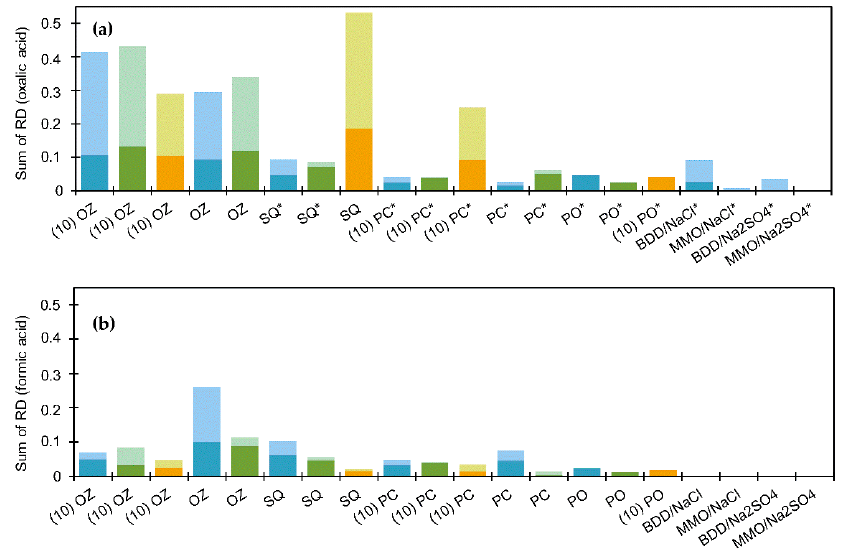
Figure 6. Presence of ( a ) oxalic and ( b ) formic acid in early and later degradation stages (quantified by relative descriptor, RD, according to Equation (5) in Section 2.4) of phenol (PHN), 2,4-dichlorophenol (DCP) and pentachlorophenol (PCP) reached by ozonation (OZ), photocatalysis (PC), photooxidation (PO), and electrooxidation (EO) with BDD and MMO anode in NaCl and Na 2 SO 4 .